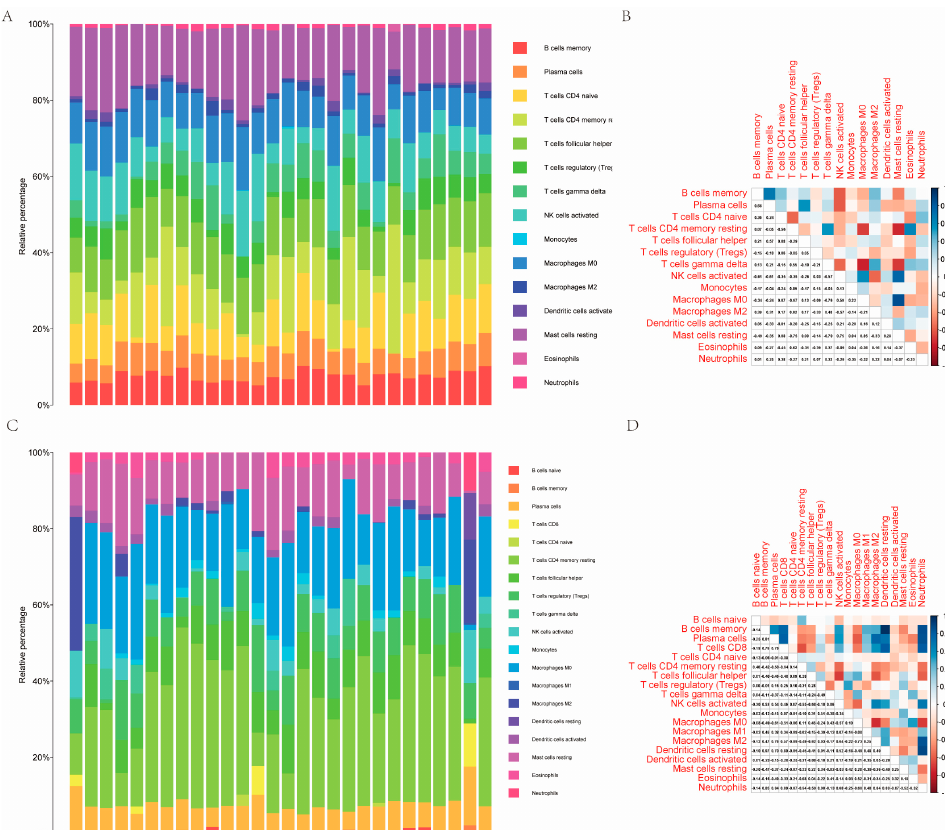
Figure 10. Evaluation and visualization of immune cell infiltration in the GSE44593 and GSE54566 datasets. ( A ) Heat map of enriched immune cell distribution in the GSE44593 dataset. ( B ) Correlation analysis of enriched immune cells in the GSE44593 dataset. ( C ) Heat map of enriched immune cell distribution in the GSE54566 dataset. ( D ) Correlation analysis of enriched immune cells in the GSE54566 dataset.